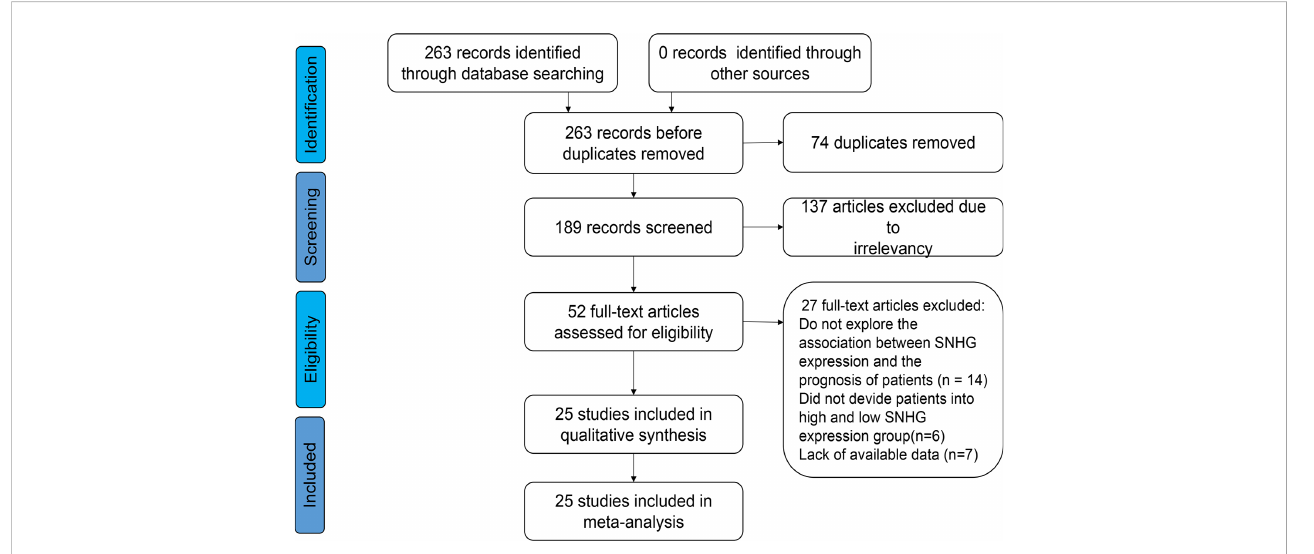
FIGURE 1 Flow diagram of the eligible